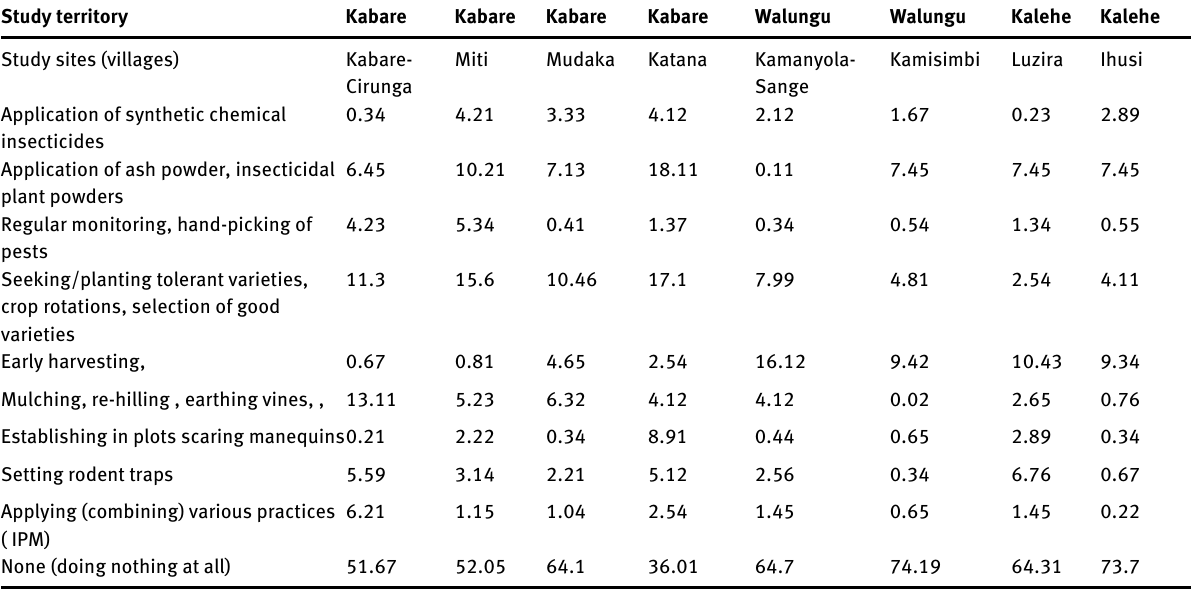
Figure 2. Major insect pests experienced by farmers in sweet potato (% households) : Ranking of Pests in terms of pest status (prevalence) from questionnaire response from major crop growers of South-Kivu Province Table 2. Control methods for the most important insect pests of sweet potato (%